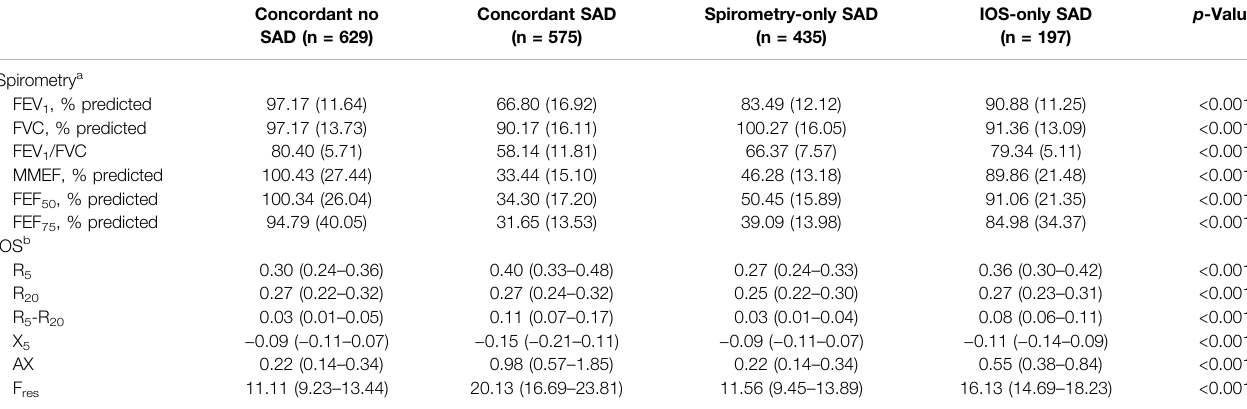
TABLE 3 | Lung function features of SAD patients diagnosed by IOS and spirometry in all